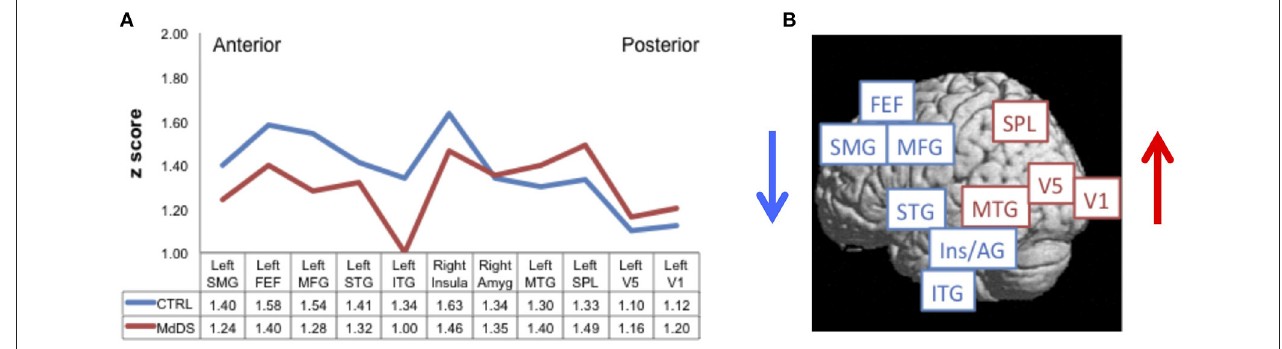
FIGURE 2 | Resting-state functional connectivity reflected by Pearson correlation coefficients converted to z -scores (A) between the left entorhinal cortex/amygdala seed of hypermetabolism [entorhinal cortex/amygdala (EC/AG)] and regions of hypometabolism [left superior medial gyrus (SMG), left middle frontal gyrus (MFG), left superior temporal gyrus (STG), left inferior temporal gyrus (ITG), right insula (Insula), right amygdala (Amyg), and left middle temporal gyrus (MTG)], functionally defined frontal eye fields (FEF), motion-sensitive area V5 (V5), primary visual cortex V1 (V1), and anatomically defined superior parietal lobule (SPL). Connectivity for MdDS is shown in red; Controls (Ctrl) in blue. Connectivity differences of anterior to posterior nodes between MdDS and Ctrl participants are shown pictorially in (B) . Figure adapted from Cha YH et al., PLOS One 2012 (